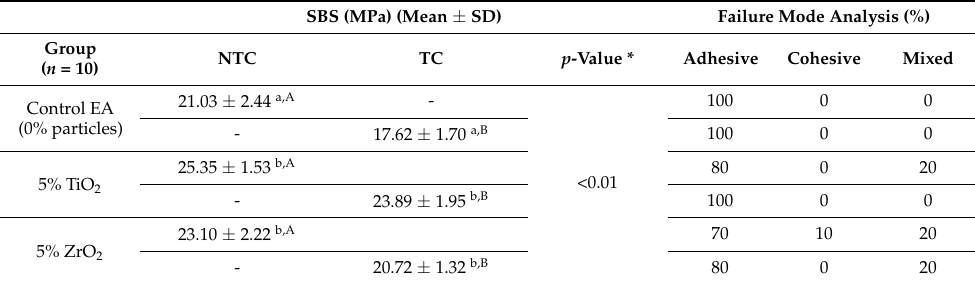
Table 1. Shear-bond strength (SBS) and failure mode analysis among the study